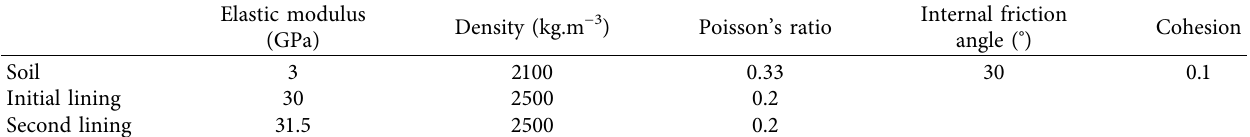
Table 1: Material parameters.